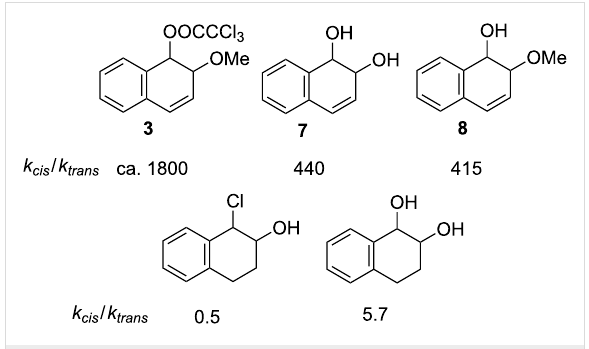
Figure 4: Cis / trans reactivity ratios for β -hydroxycarbocation forming